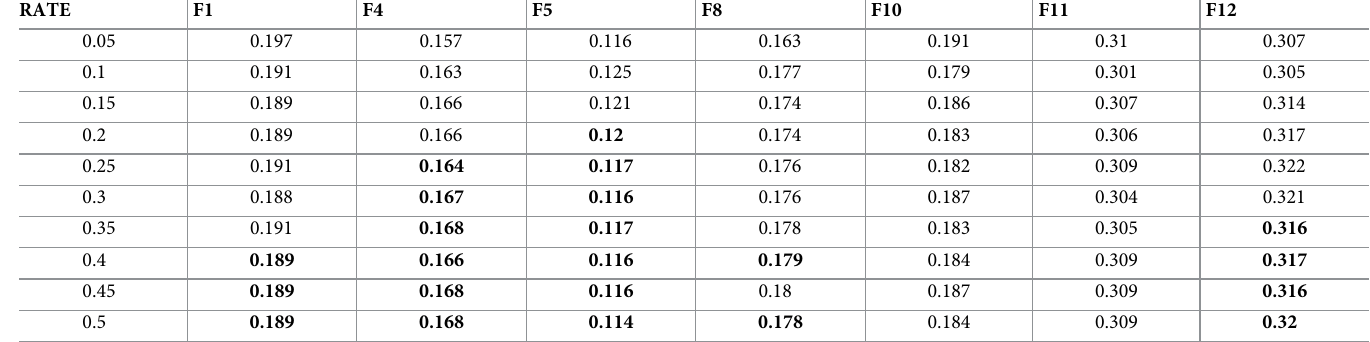
Table 18. RMSE of mode replacement by